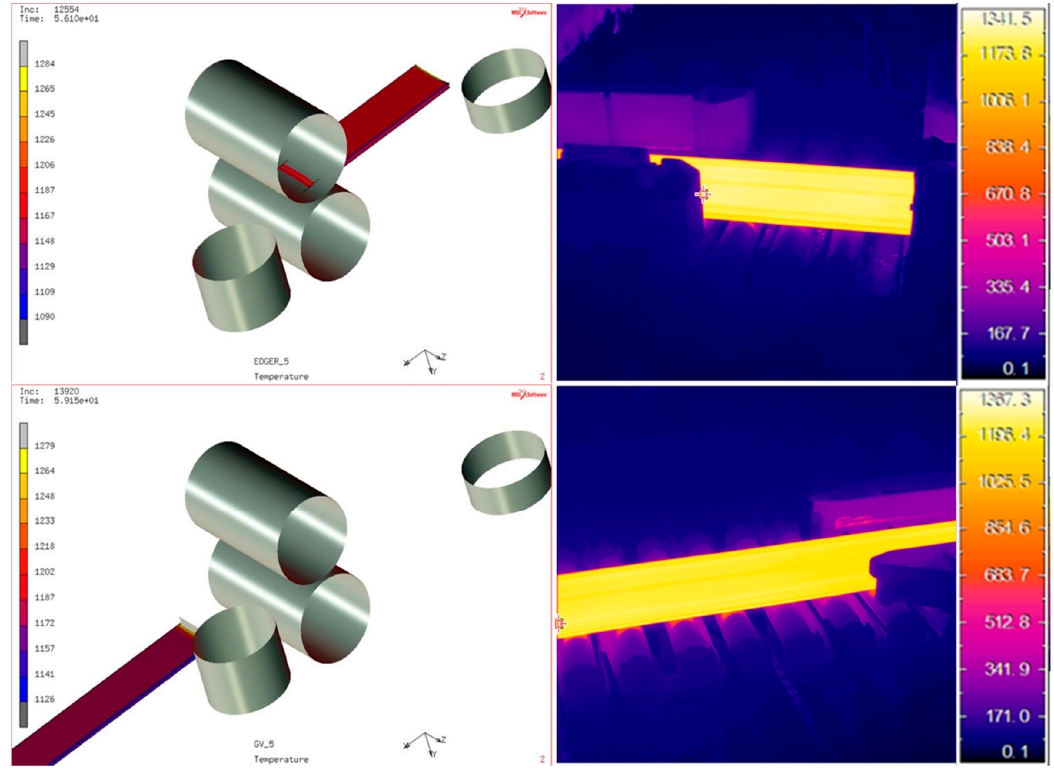
Figure 7. FE Thermomechanical 3D model of the hot rolling of flat bar compared to temperature experimental measures.